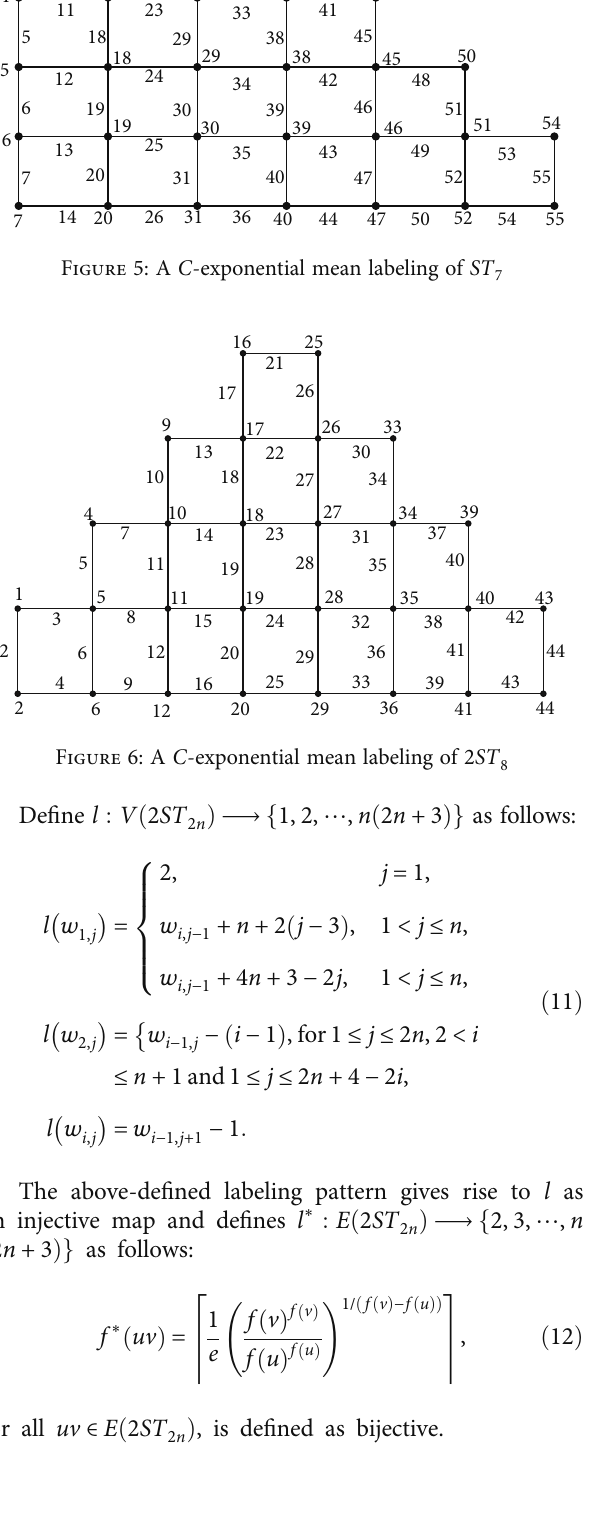
Figure 7: A C -exponential mean labeling of A 2